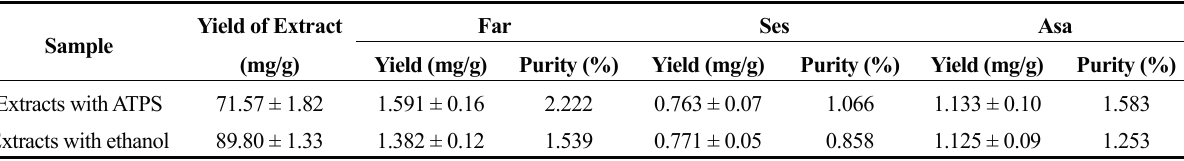
Table 2. Comparison of ATPS and conventional reflux extraction